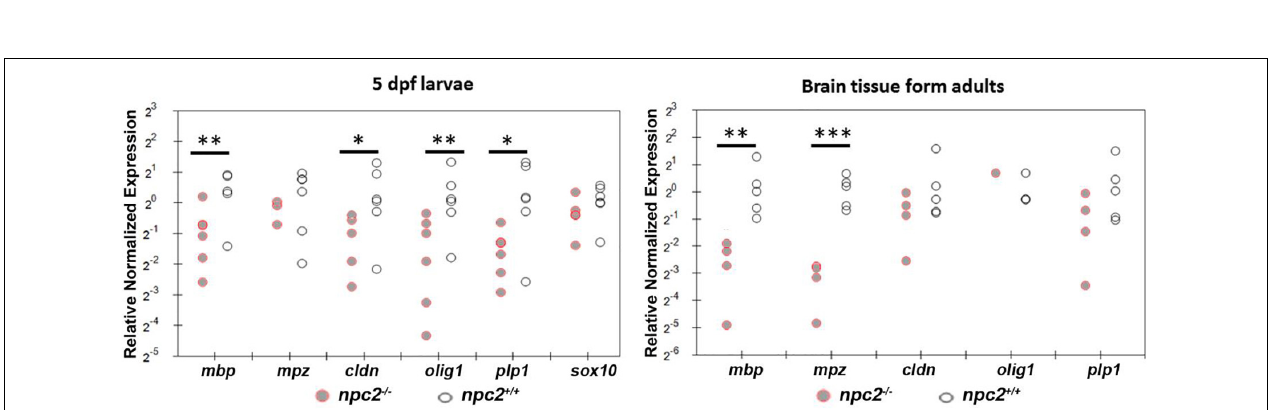
FIGURE 8 | Decrease in myelination in npc2 -deficient larvae and adult fish. Scatter plots show the normalized expression of selected genes in 5 dpf larvae and in the brain in npc − / − and wildtype zebrafish. Each circle corresponds to one zebrafish. The 18 S ribosomal gene was used as a reference. At least three samples were analyzed. *** p < 0.001; ** p < 0.01; and * p < 0.05.